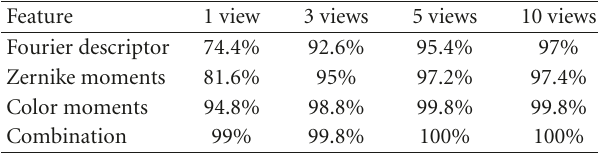
Table 1: Comparison of results with queries comprising 1, 3, 5, and 10 views in